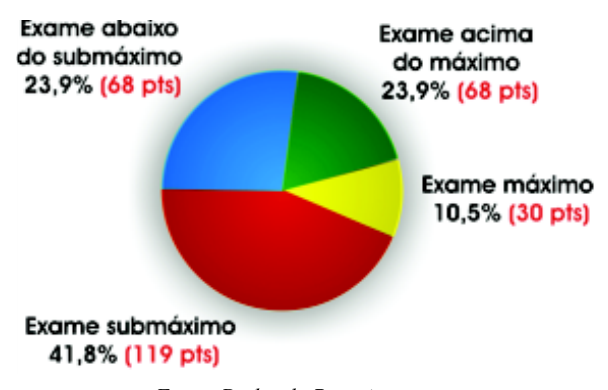
Fonte: Dados da Fig. 3 – Comportamento da freqüência cardíaca nos idosos durante a EEEF